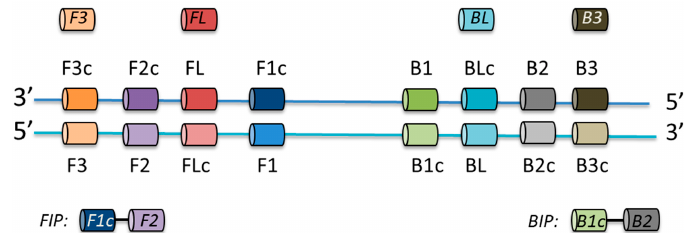
Figure 1. Cartoon outlining the relative positioning and relationships between the primers required for a LAMP assay.